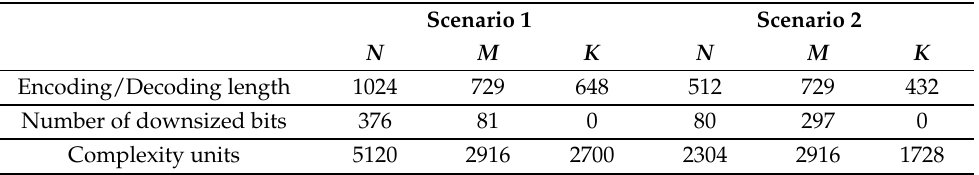
Table 4. Complexity comparison of the polar code designs.